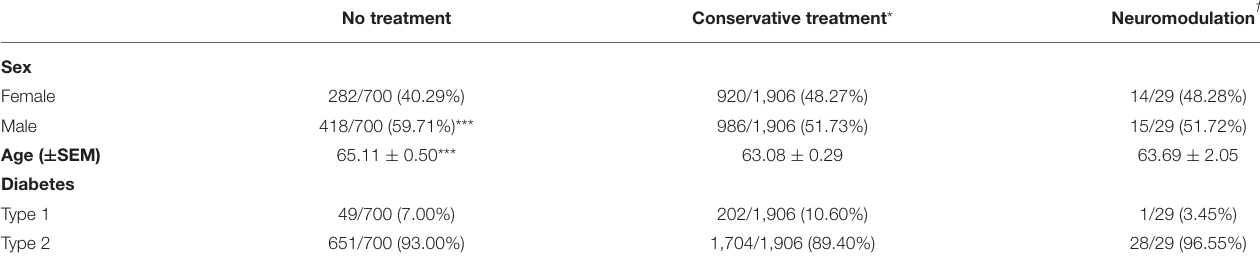
TABLE 1 | Patient demographics among each